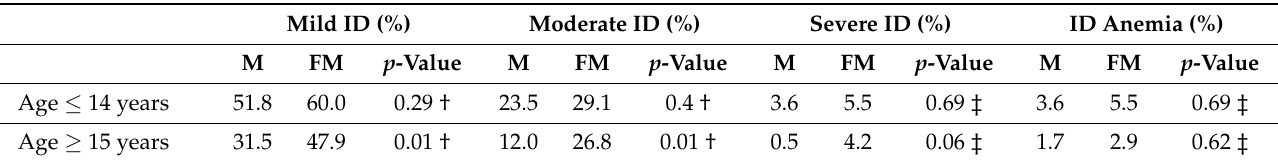
Table 2. Prevalence of mild, moderate, severe ID and ID anemia in male and female adolescent athletes according to age groups.